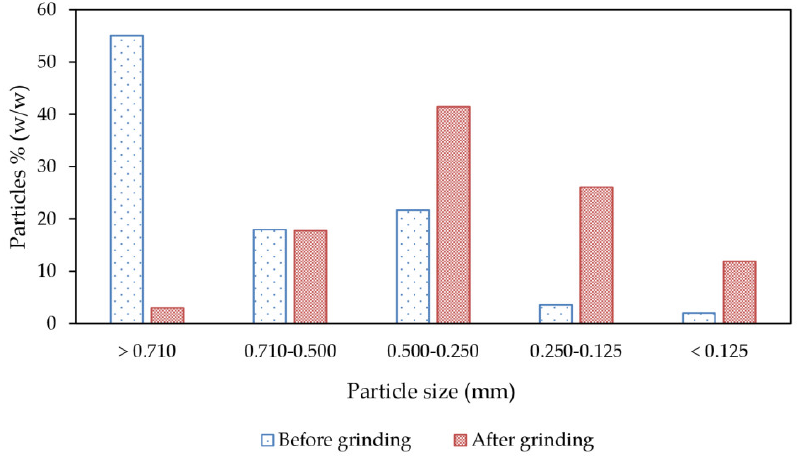
Figure 2. BSG-particle size distribution before the grinding process and after the grinding